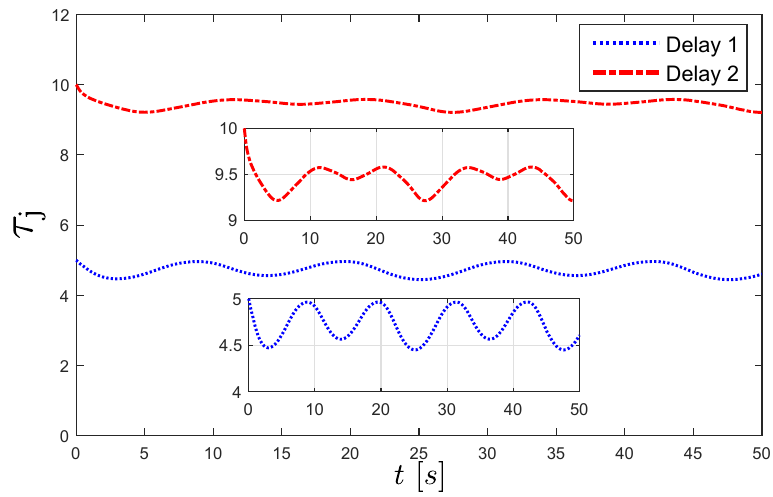
Figure 8. Time evolution of the delay for the second trajectory. Table 2. RMS errors of distance, orientation and observed orientation of the robots in the circular trajectory experiment.